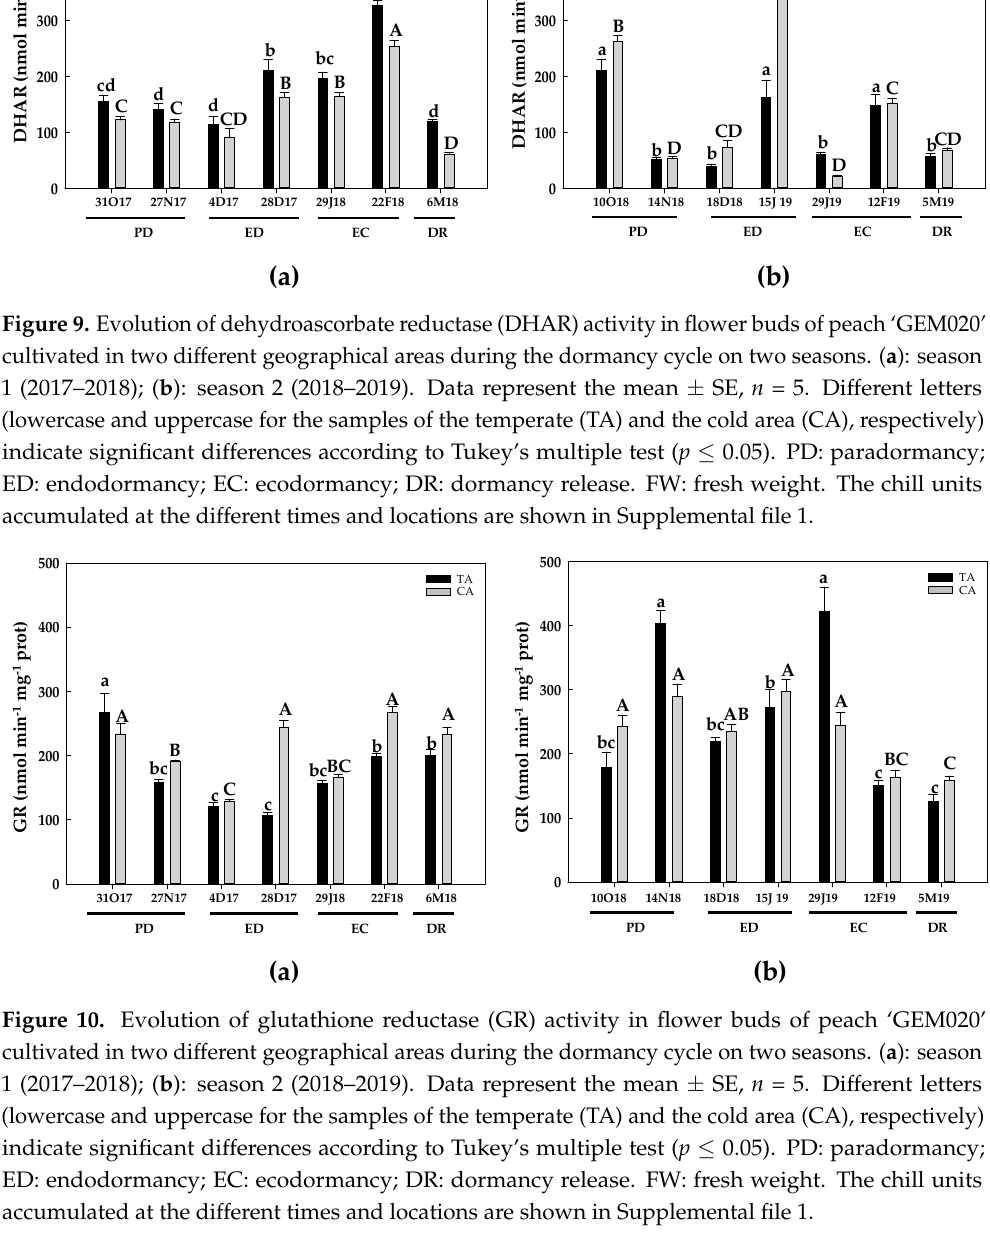
paradormancy; ED: endodormancy; EC: ecodormancy; DR: dormancy release. FW: fresh weight. The chill units accumulated at the different times and locations are shown in Supplemental file 1.